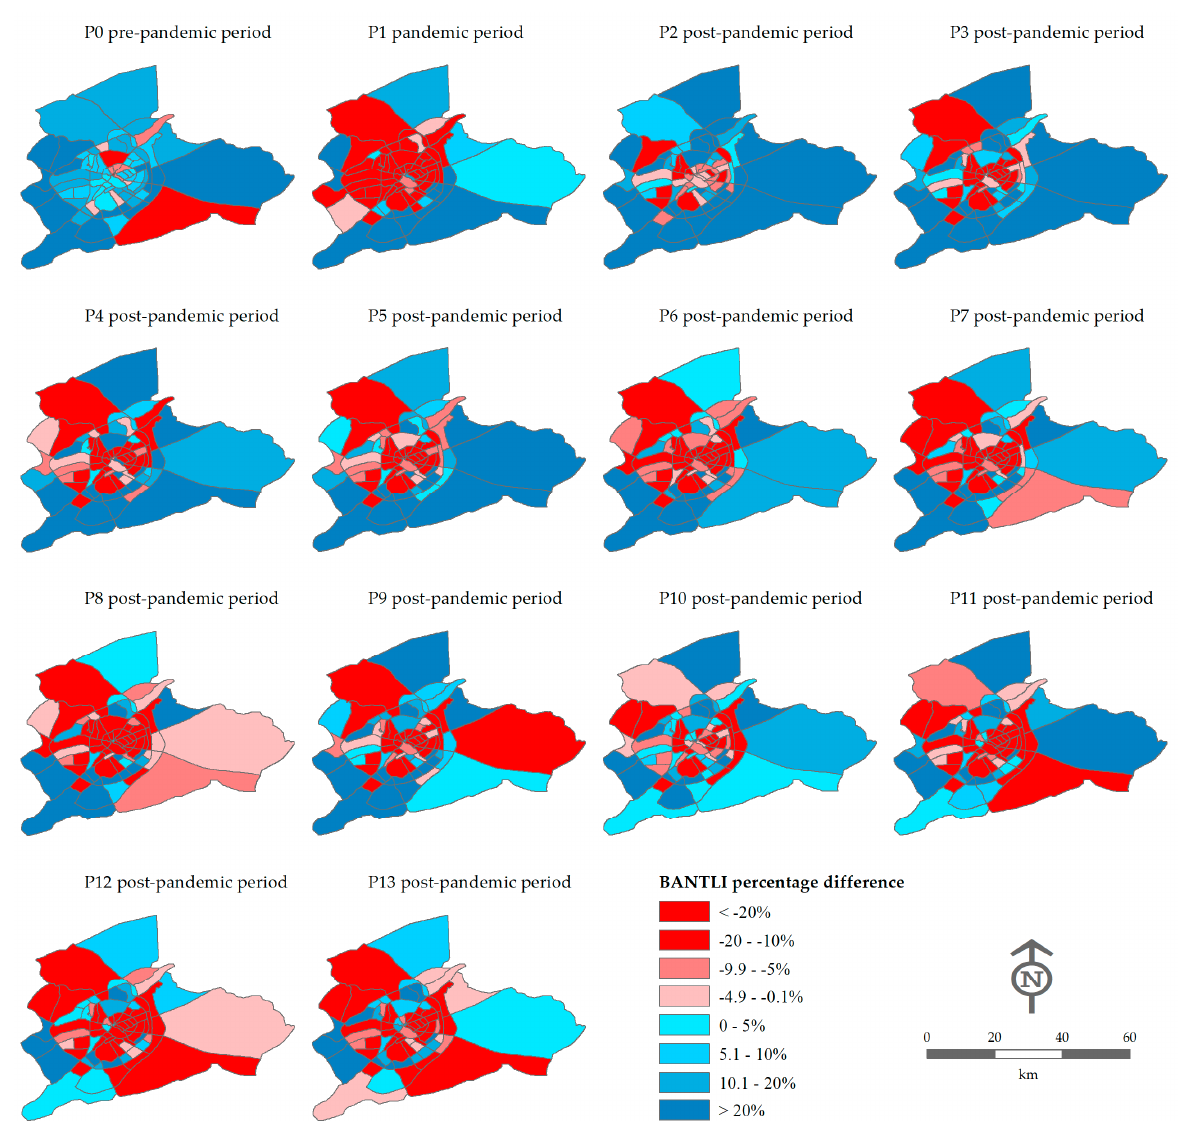
Figure 12. Maps of percentage difference in BANTLI radiance for the pre-pandemic (P0), pandemic (P1) and post-pandemic (P2 to P13) periods in Madinah at the ward level.